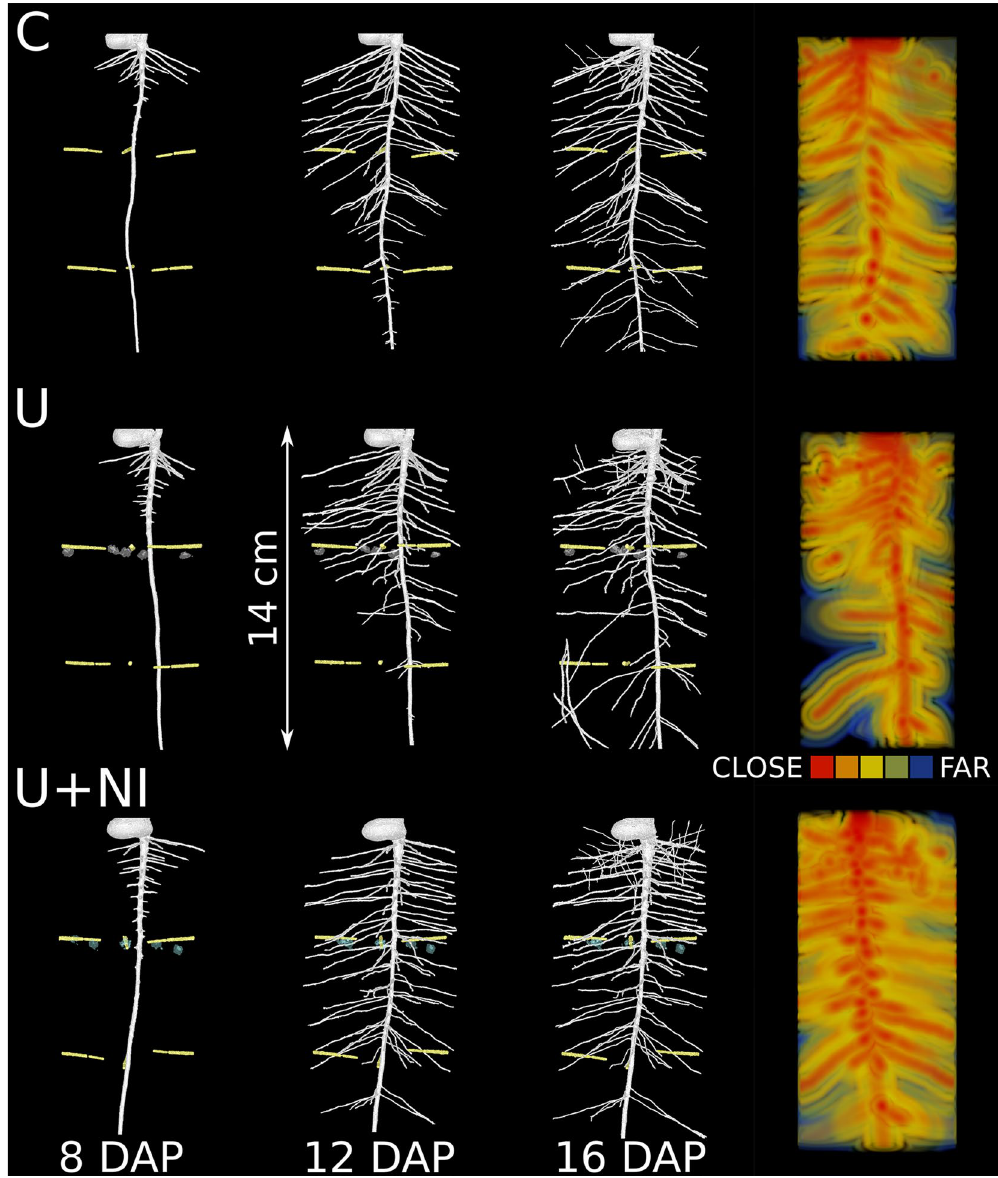
Figure 6. Time series of root growth development of Vicia faba for all three treatments (characteristic representatives for control (“C”), urea (“U”) and urea with nitrification inhibitor (“U+NI”) and visualisation of relative frequencies of soil-root-distances (representative layers) in 2 mm steps. Micro suction cups are represented in yellow. Remaining voids from fertiliser granules are indicated in grey (middle row) for urea and turquoise (bottom row) for urea with